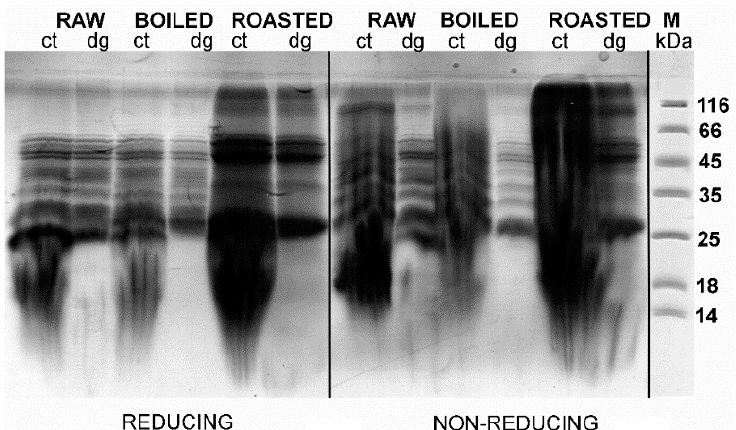
Figure 2. SDS-PAGE protein profiles of non-defatted raw, boiled, and roasted peanut gastric digests and corresponding controls. SDS-PAGE was performed in reducing and non-reducing conditions on 14% gels; ct—control at 120 min; dg—digest at 120 min; M—molecular weight markers.